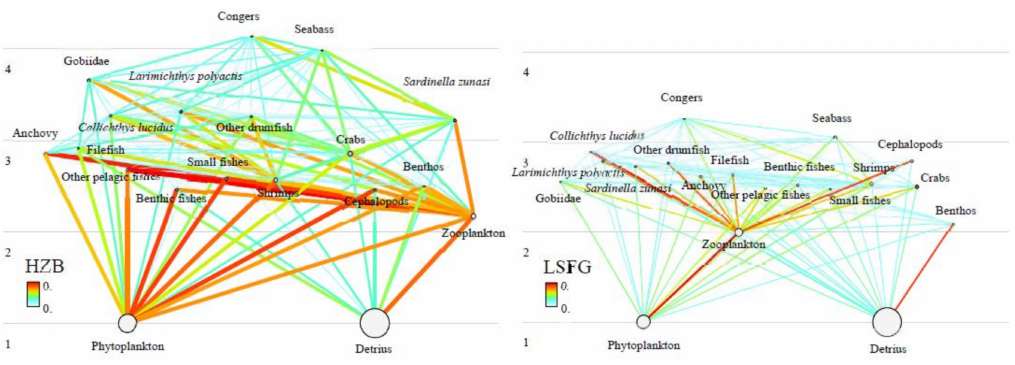
Figure 2. Flow diagram of two models. Table 2. Model parameters for 19 functional groups in two models. Bold represents the basic